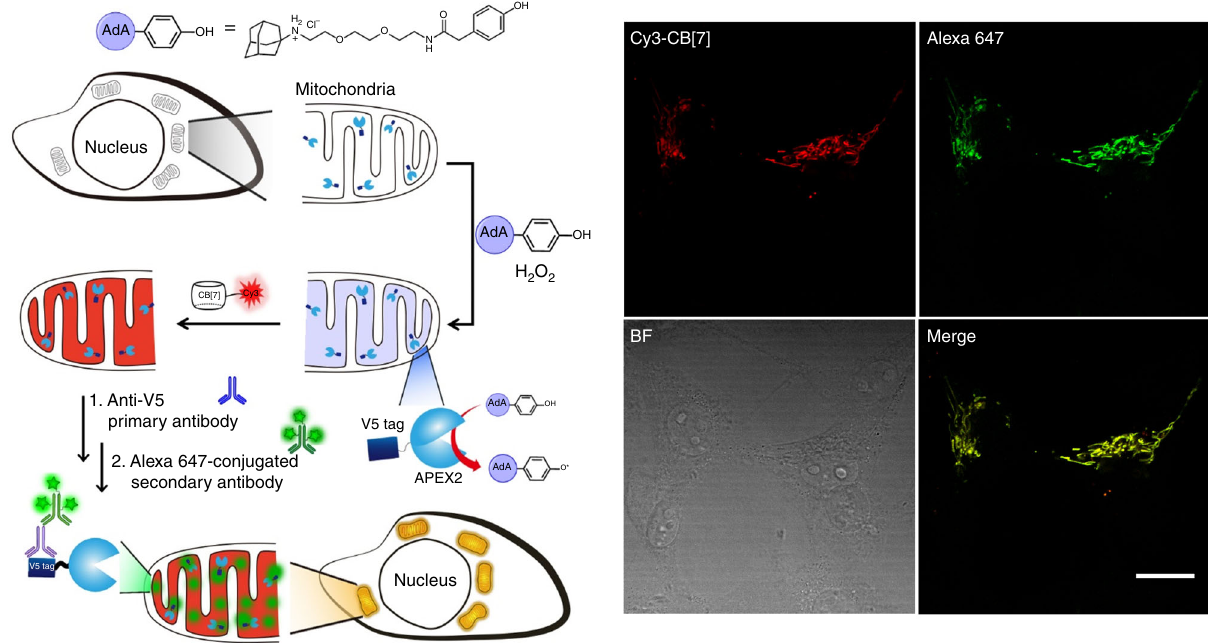
Fig. 6 Visualization of a subcellular organelle (mitochondria). Schematic illustration for proximity-dependent adamantylation to mitochondria proteins using mito-V5-APEX2 and immuno fl uorescence labeling of mito-V5-APEX2, and confocal laser scanning microscopy images of living COS7 cells which have mito-V5-APEX2 expressed in mitochondria. Scale bar = 20 μ